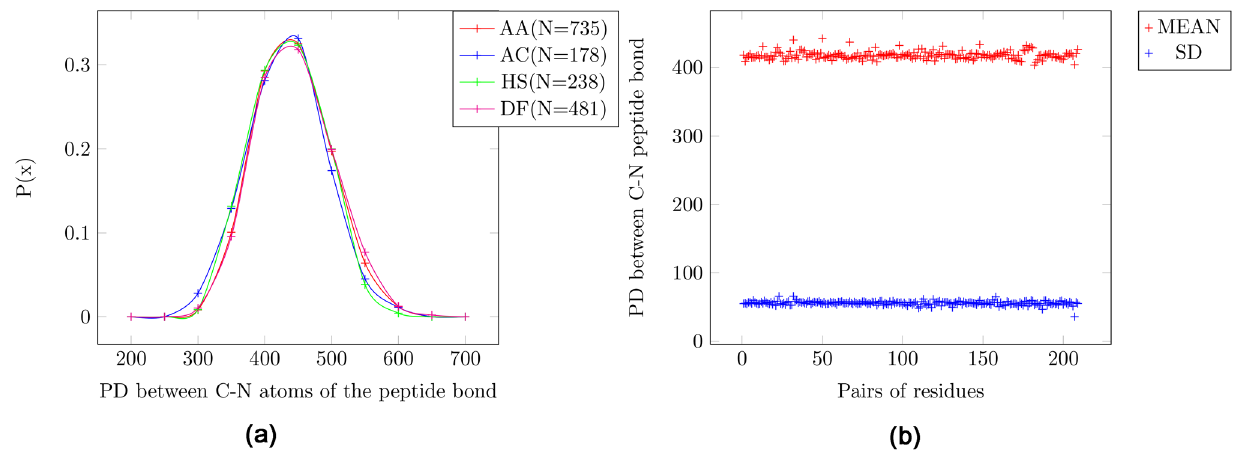
Figure 1. Electrostatic potential differences (PD) for the C-N peptide bond. AA: Alanine/Alanine, AC: Alanine/Cysteine, HS: Histidine/Serine and DF: Aspartic-acid/Phenylalanine. ( a ) Probability distribution for four pairs of amino acids. ( b ) Scatter plot for all pairs of amino acids. It can be seen that the mean and SD for all pairs of amino acids are the same. Further, the variance is large (SD=~50), indicating that this feature is not tightly constrained in peptide structures.